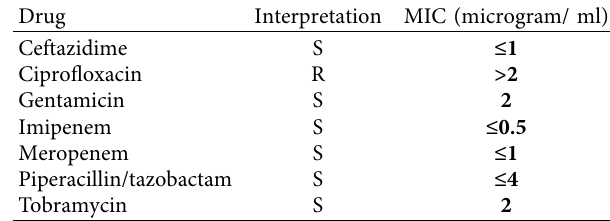
Table 1: Antibiotic susceptibility of Comamonas kerstersii